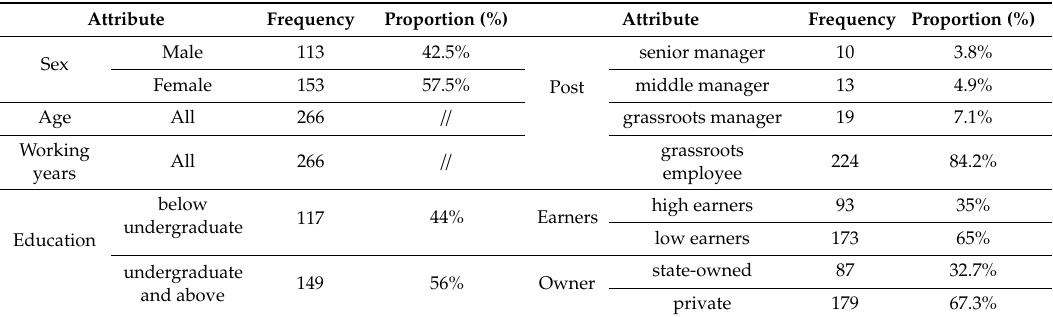
Table 1. Descriptive statistics (N =